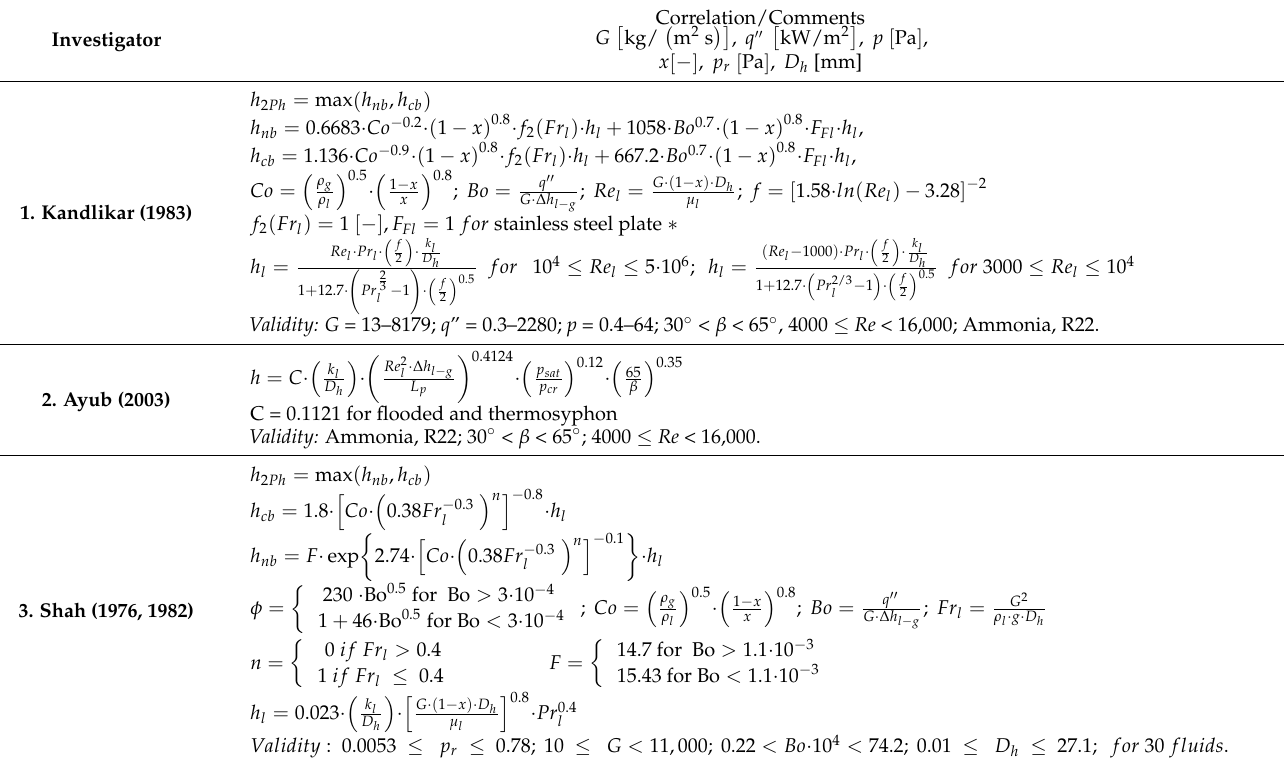
Table 1. Selected correlations for the